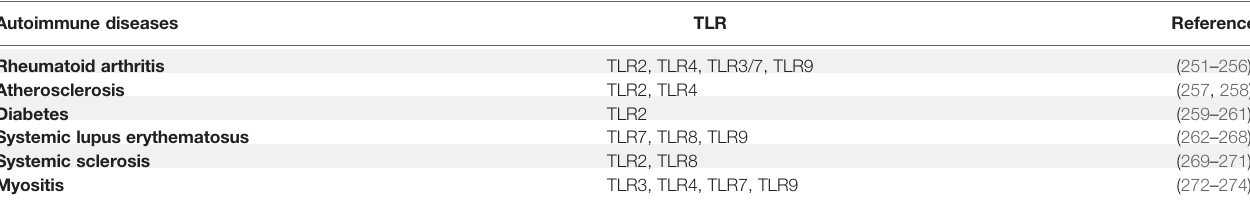
TABLE 3 | TLRs implicated in autoimmune